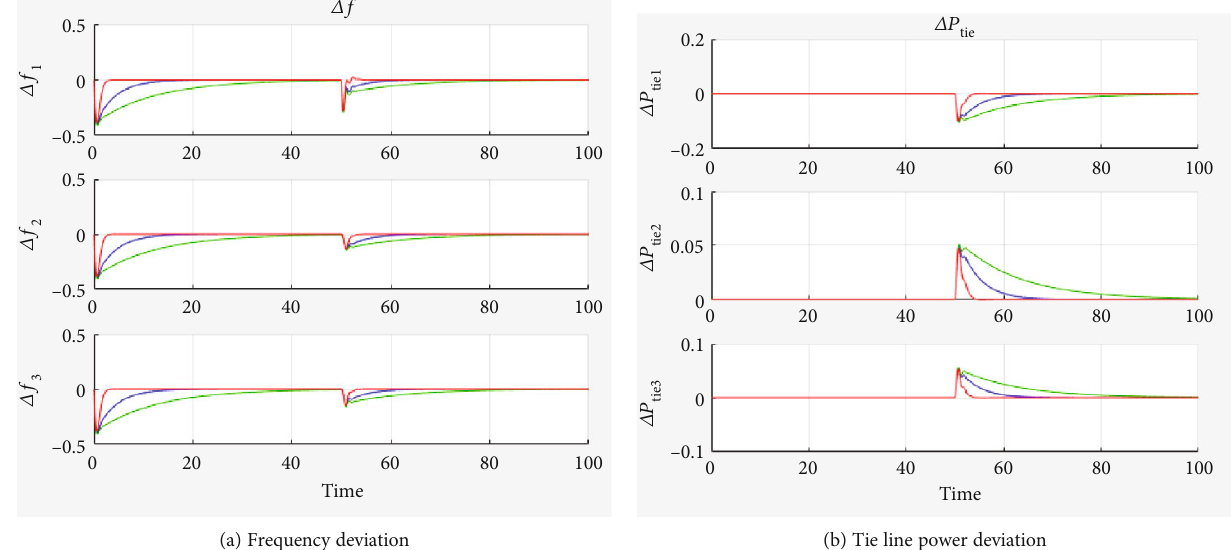
Figure 11: Response of the system under sudden load change from 0.2 to 0.4 p.u in area 1 at 50